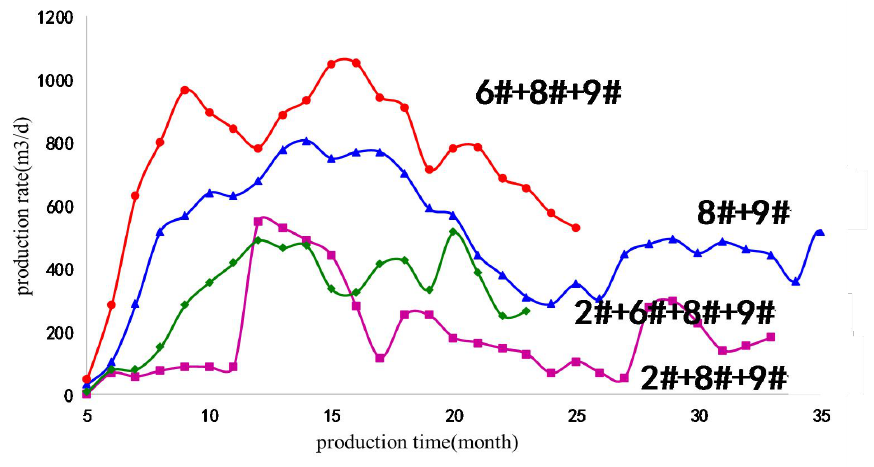
Figure 2—Different production rate with different layer